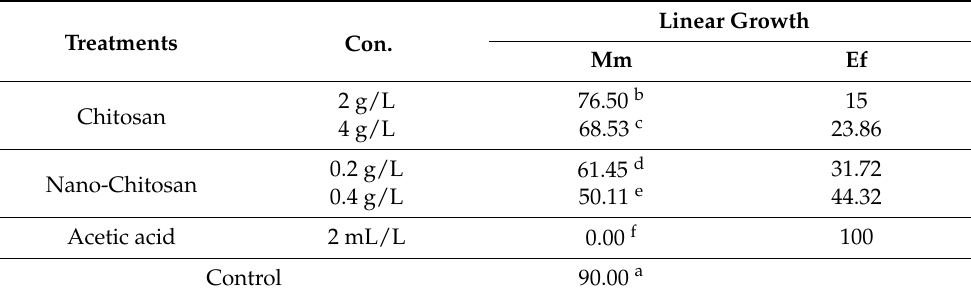
Table 2. Effect of chitosan and its nanoform on the growth (mm) of P. expansum in vitro .